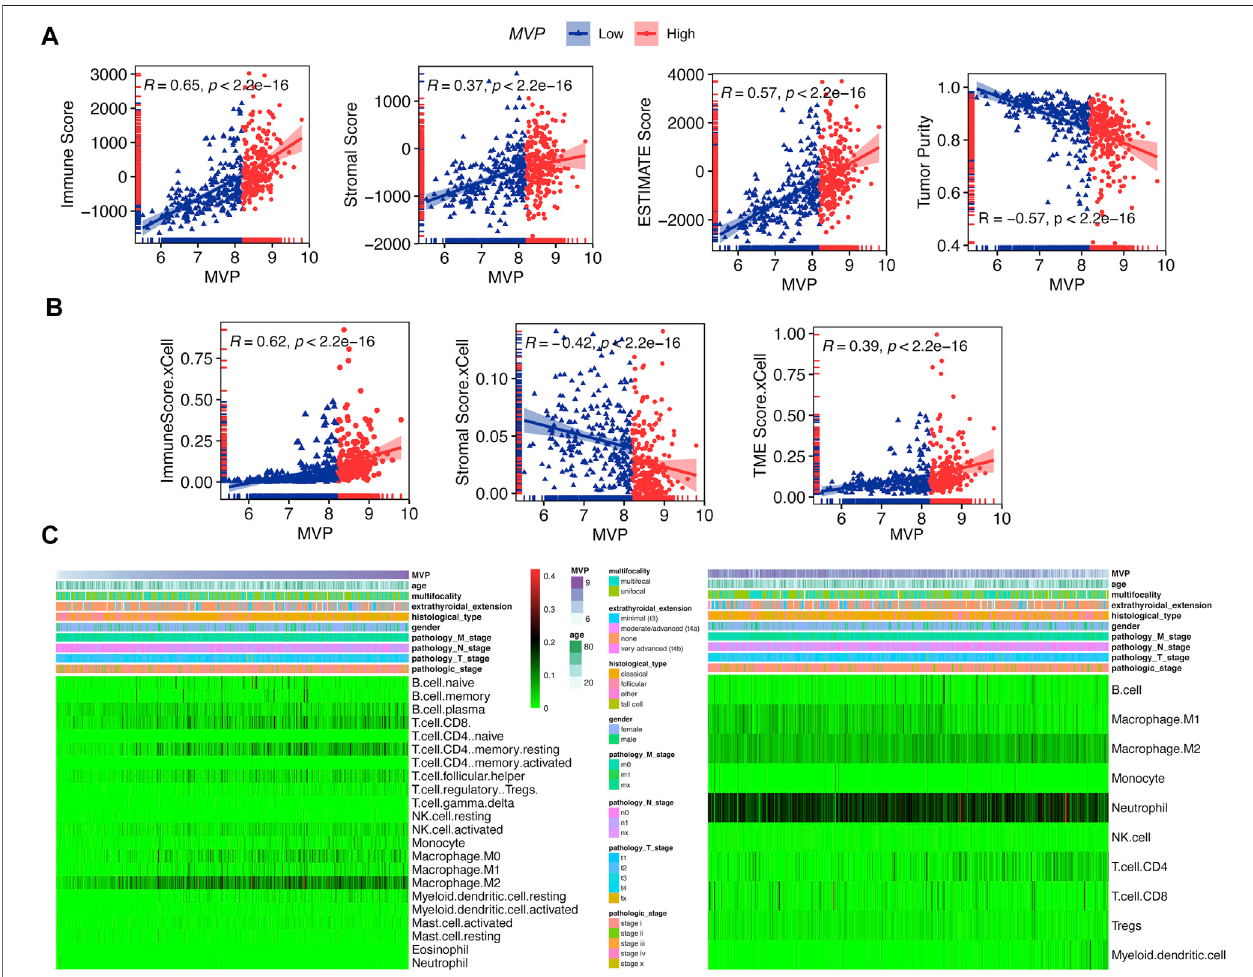
FIGURE 6 | MVP interacted with TIME phenotype. (A) Spearman ’ s correlations between MVP level and immune, stromal, microenvironment scores, and tumor purity by ESTIMATE. (B) Spearman ’ s correlations between MVP level and immune, stromal, and microenvironment scores by xCell. (C) Pro fi les of TIICs in PTC immune microenvironment assessed through CIBERSORT and quanTIseq